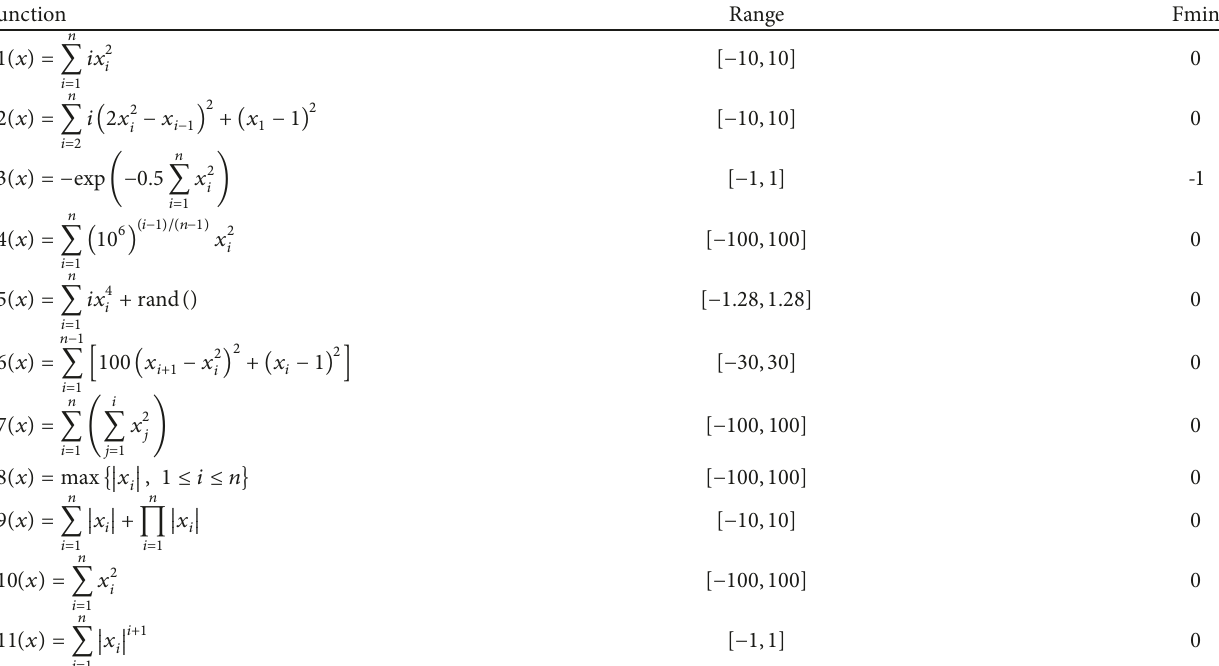
Table 2: Unimodal benchmark